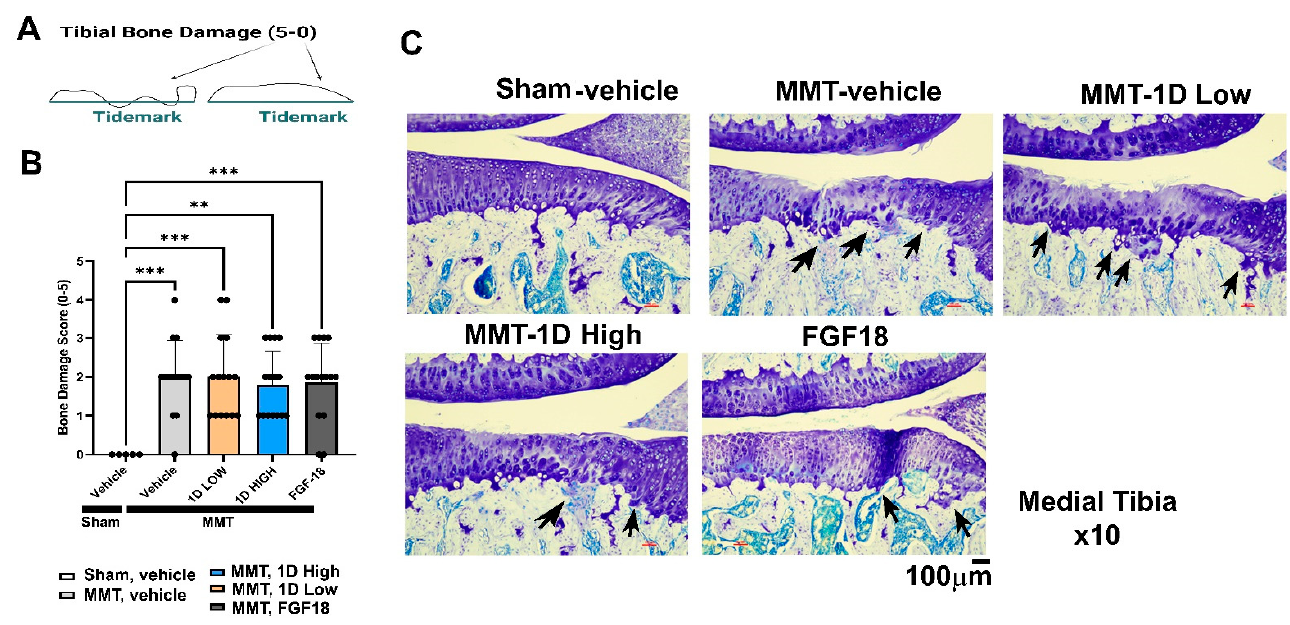
Figure 7. Histopathology for post-MMT Medial Tibial Bone damage. Bone damage is illustrated in ( A ) and exhibited in graphs ( B ). ( C ) exhibits representative sections showing black arrows pointing at the subchondral bone morphology for each group. Statistical significance between treatments and control was examined via Kruskal–Wallis test with a Dunn’s post hoc analysis for scored (non- parametric) parameters, considering to be statistically significant. ** p < 0.01; *** p < 0.001. Sham, n = 5; MMT-Vehicle n = 15; MMT-1D, low dose 8 µg n = 15; MMT-1D, high dose 24 µg n = 15; and MMT-FGF18 3 µg n = 15.